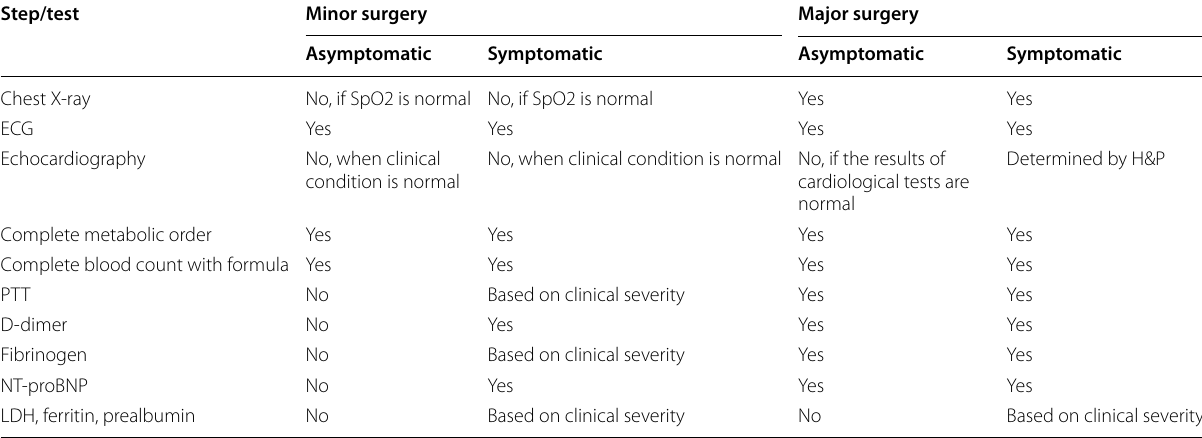
Table 1 Preoperative assessment protocol for patients with previous COVID-19 based on the type of surgery and the severity index of the disease